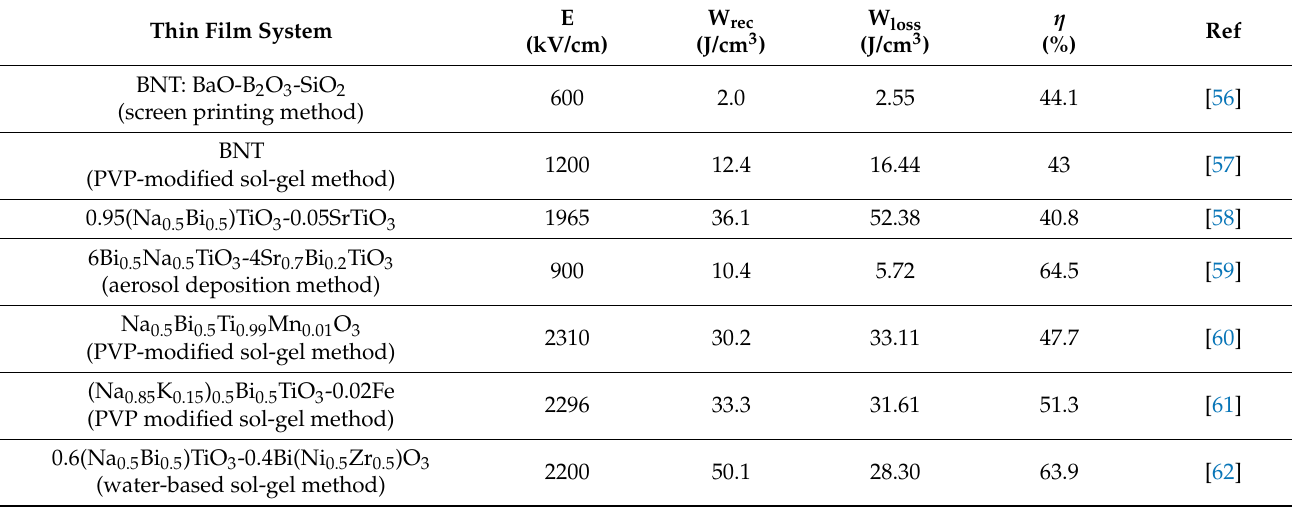
Table 6. ESP of BNT-based thick